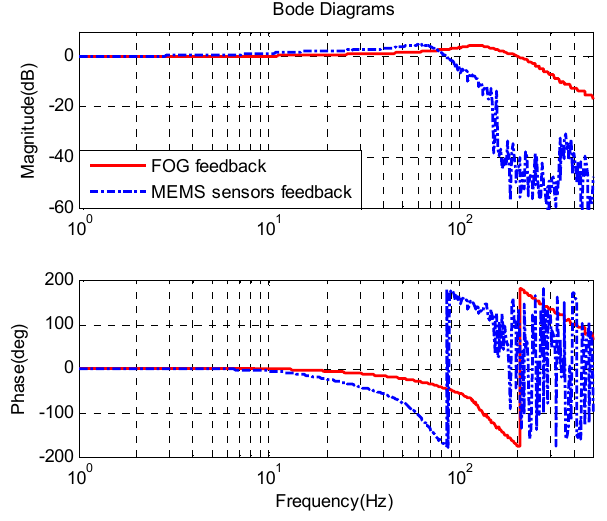
Figure 11. FSM velocity response.